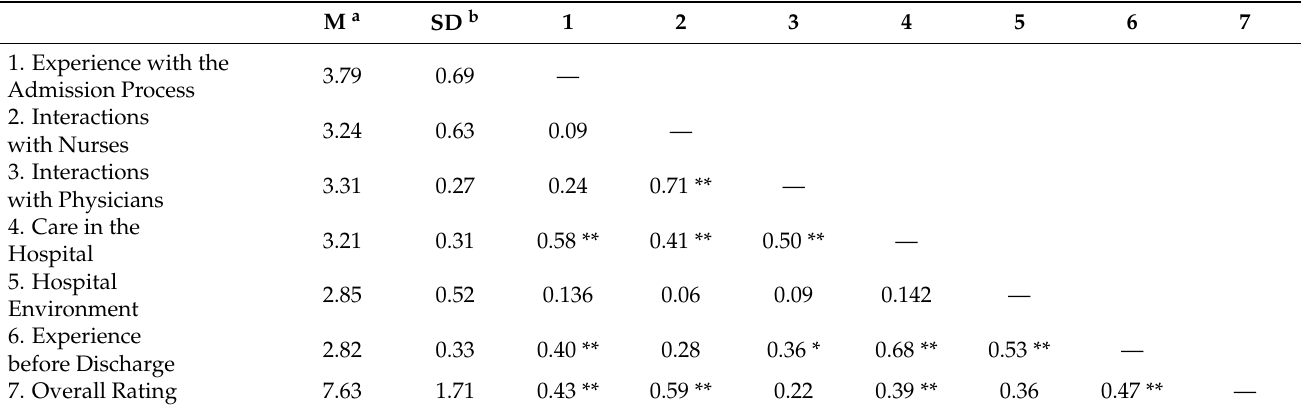
Table 2. Pearson correlation analysis—children’s